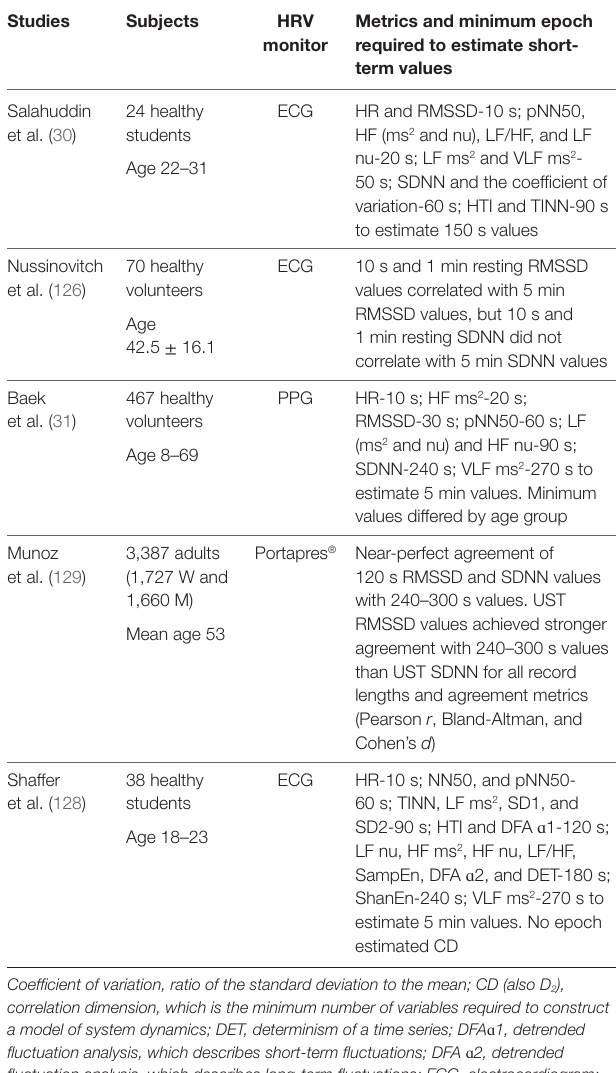
TABLe 4 | Ultra-short-term (UST)